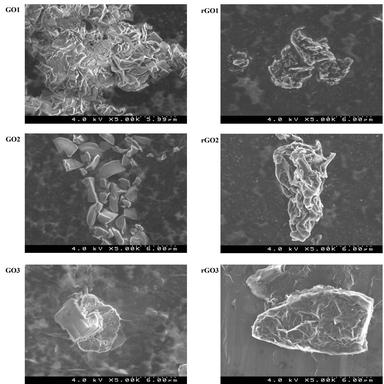
SEM images of GO (left) and rGO samples (right).